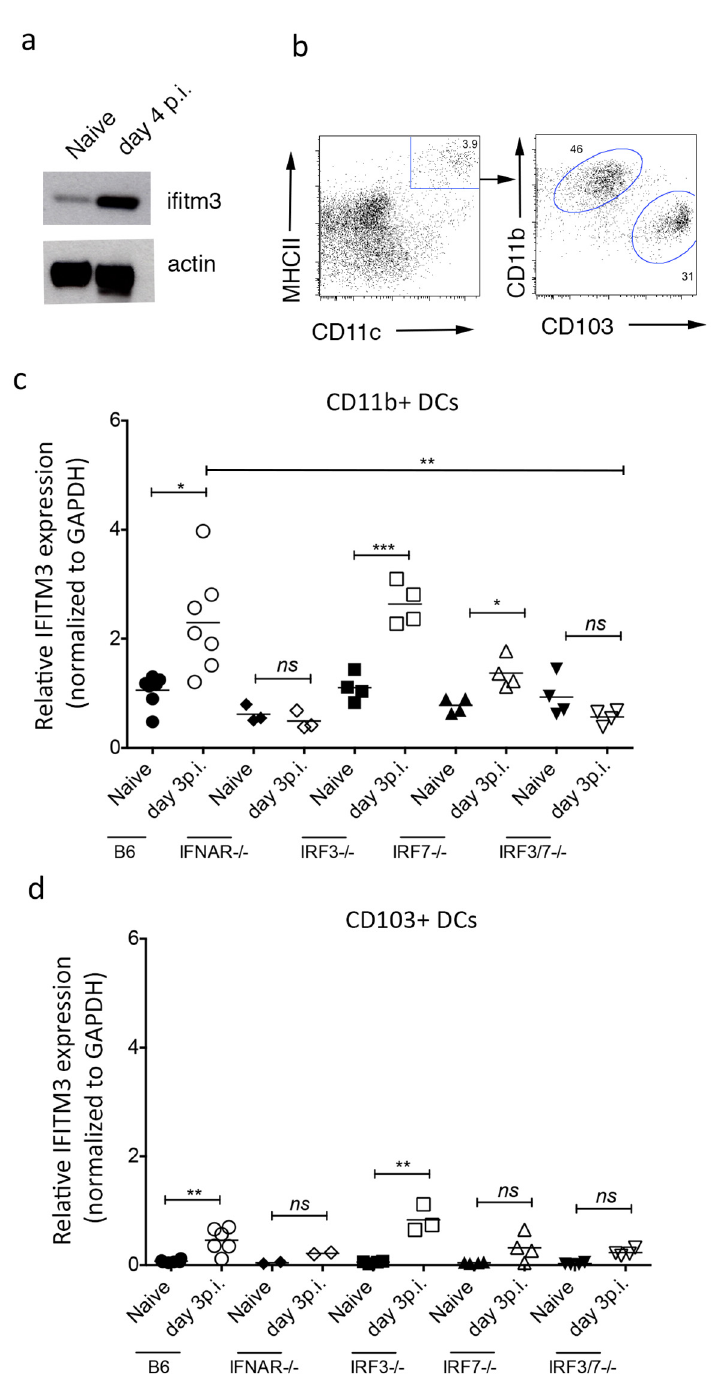
Fig 1. Influenza virus induced up-regulation of IFITM3 on respiratory APCs is dependent on type I interferon signaling. (a) The expression of IFITM3 protein in bulk DCs sort purified from the lung of mice either before (na ï ve) or 4 days after intranasal infection with IAV. (b) Representative flow cytometry profiles depicting the two DCs populations in the mouse lung. The expression of IFITM3 mRNA measured by real time PCR in (c) CD11b+ DCs and (d) CD103+ DCs sort purified from the lungs of B6, IFNAR-/-, IRF3 KO, IRF7 KO or IRF3/7 KO mice that were na ï ve or had been infected 3 days previously with IAV. The expression of IFITM3 mRNA in each subset was measured by real time PCR. Values normalized to the housekeeping gene GAPDH. (n = 2 – 3 mice pooled per experiment, data pooled from 4 independent experiments, Student ’ s t-test, * P < 0.05, ** P < 0.01, *** P < 0.001, ns = P > 0.05).